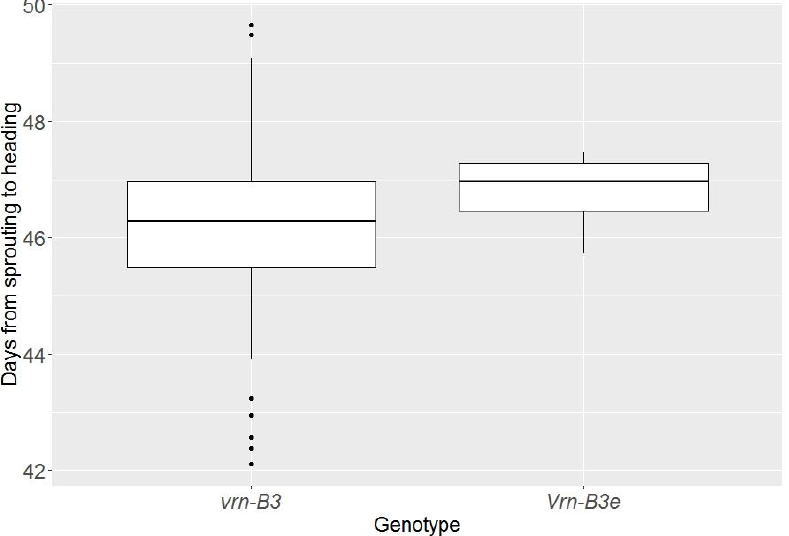
Figure 5. Boxplot of the heading times in groups of plants with vrn-B3 and Vrn-B3e alleles.